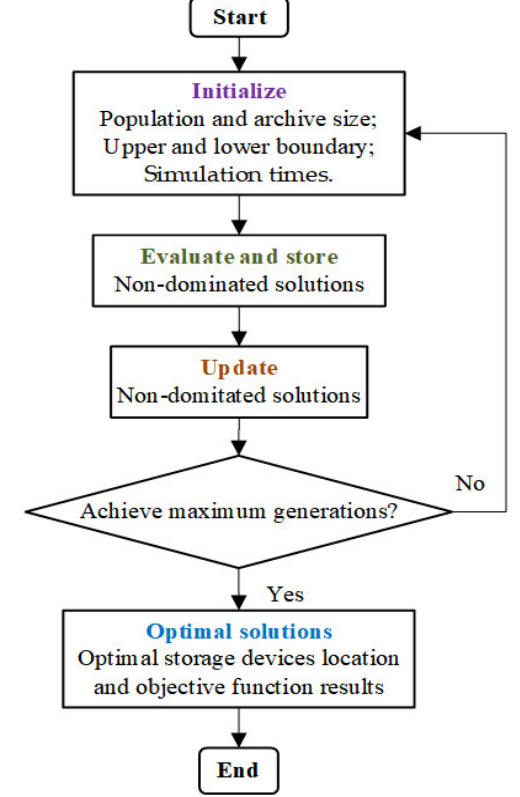
Figure 3. The reliability optimization flow chart.